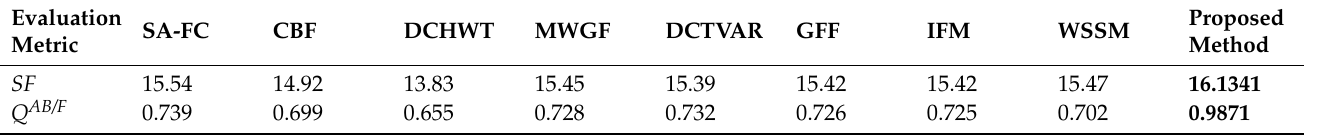
Table 15. The outcomes for the desk image and comparisons with existing techniques in the literature